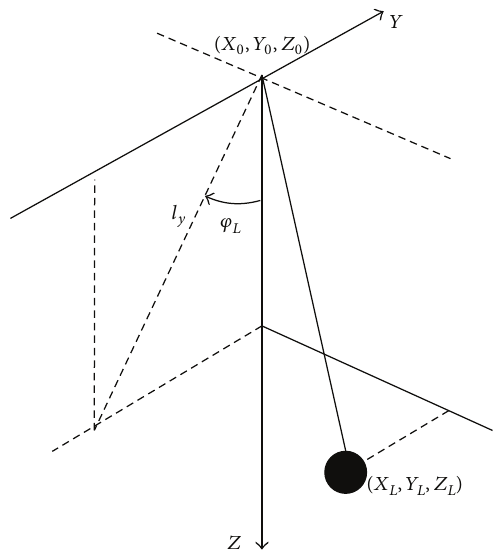
Figure 2: Coordinatesystemfor thelateral motion inthe 𝑌 - 𝑍 plane.